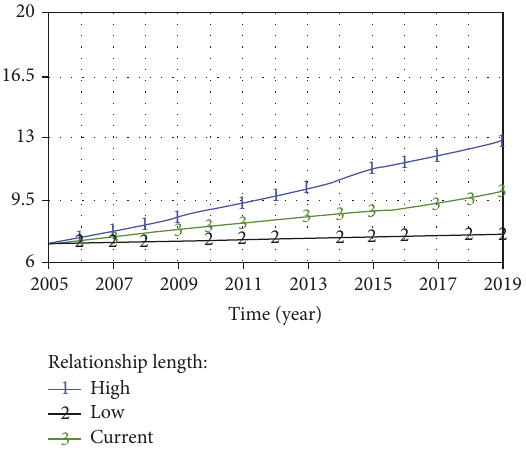
Figure 13: Influences of various trusts on relationship length (RL).